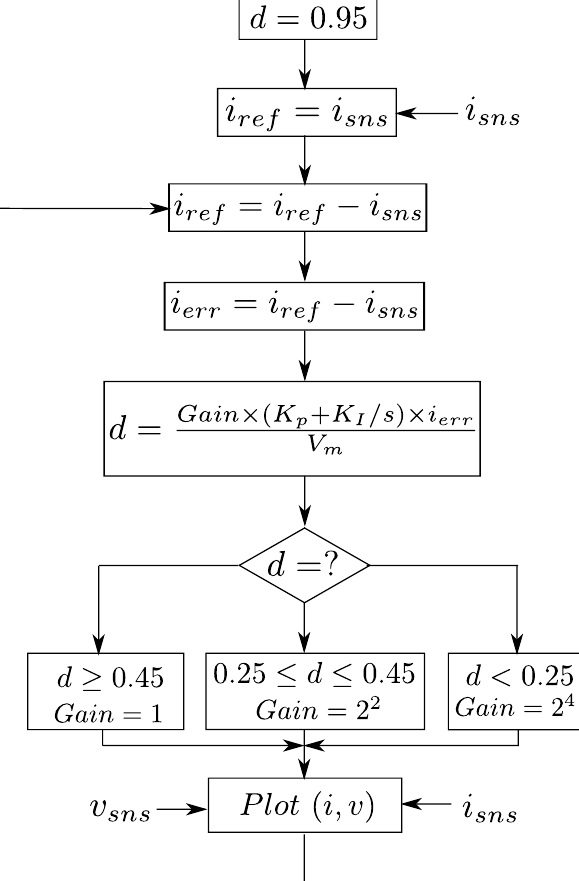
Figure 6. Complete current-voltage characterization algorithm using adaptive gain PI controller with stable operation under varying ambient